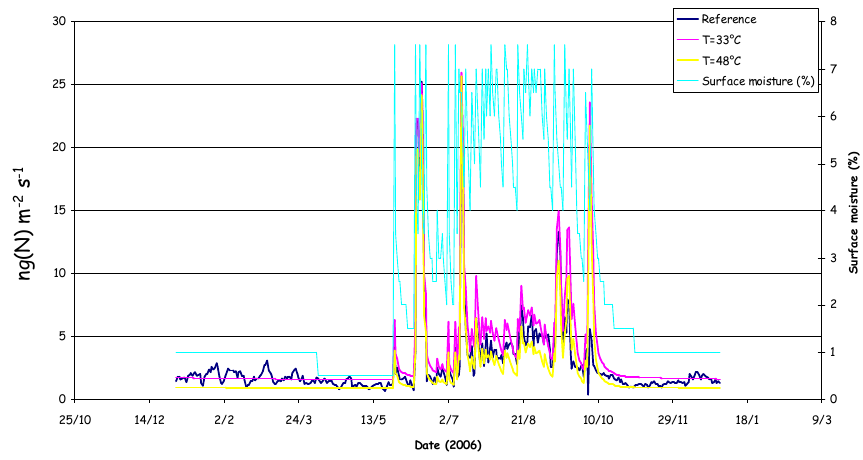
Figure 9. Sensitivity test. In dark blue: reference NO flux in kg ( N ) ha − 1 yr − 1 ; in yellow: NO flux with T = 48 ◦ C; in pink: NO flux with T = 33 ◦ C; in light blue: surface moisture in %, for year